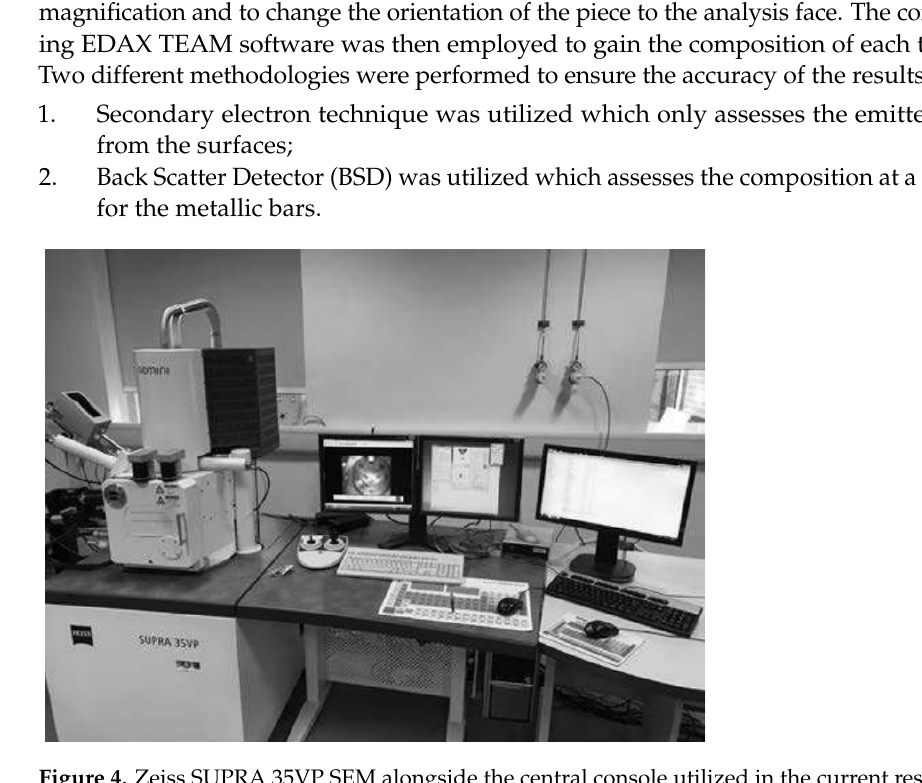
Figure 4. Zeiss SUPRA 35VP SEM alongside the central console utilized in the current